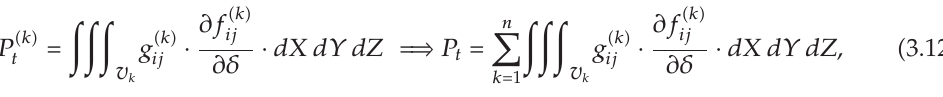
Figure 10 (cid:7) when the displacements are not confined in a small area located